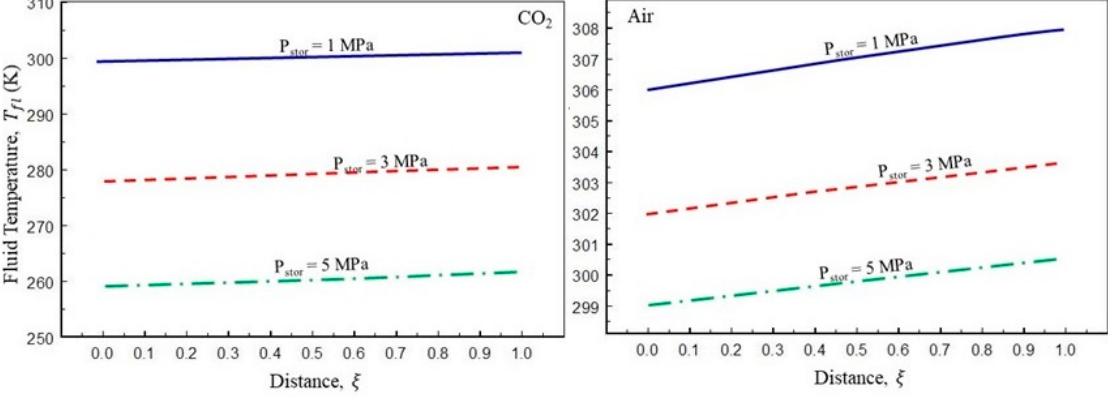
Figure 7. Effect of storage pressure on the cooling-fluid temperature (storage container temperature of 35 °C (308 K)).